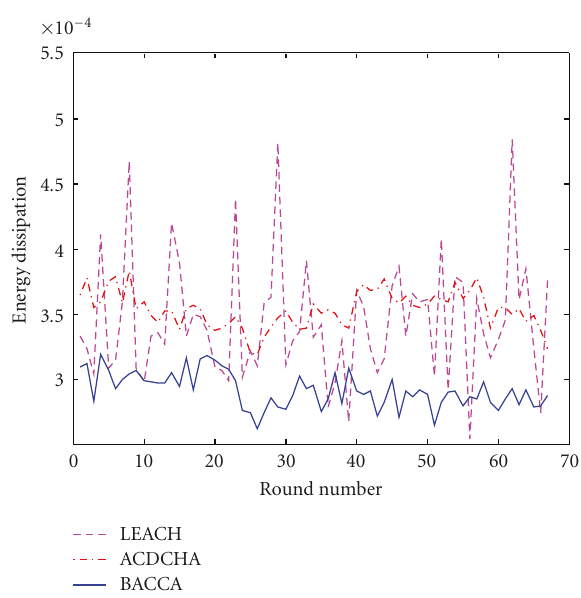
Figure 4: Energy dissipation for cluster